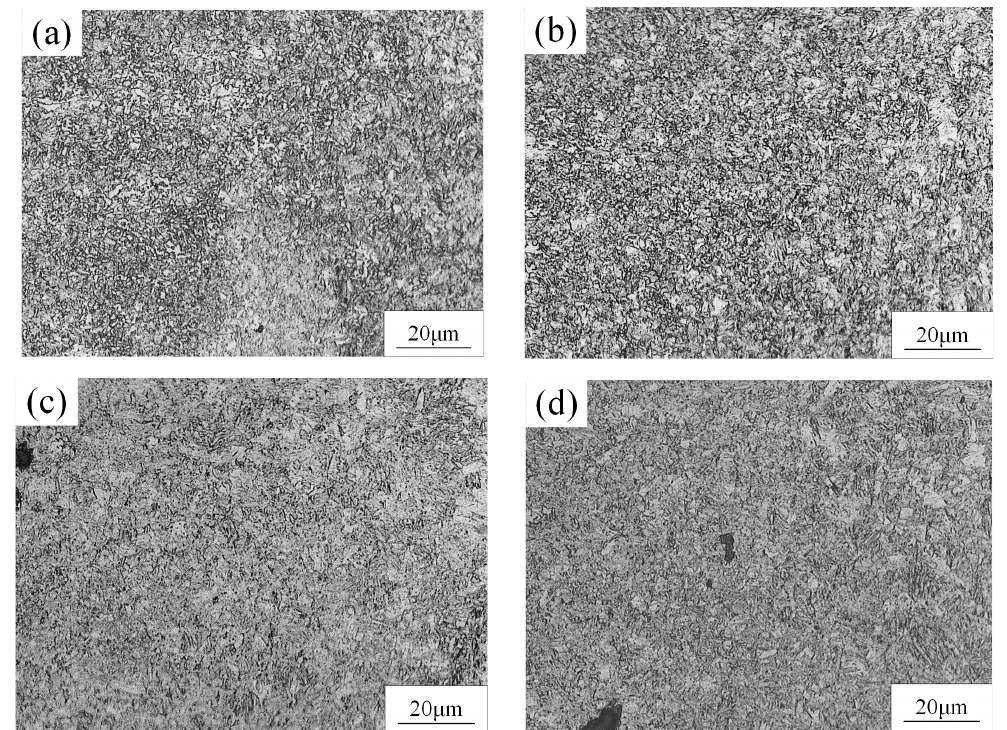
Figure 6. The microstructure of HAZ of DP 780 laser-welded joint under different welding speeds (mm/s): ( a ) 30, ( b ) 40, ( c ) 50, and ( d ) 60.